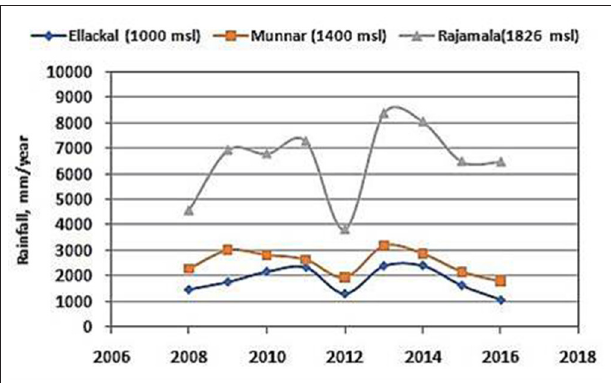
FIGURE 8 | Altitudinal effects on the mean annual precipitation in cardamom growing